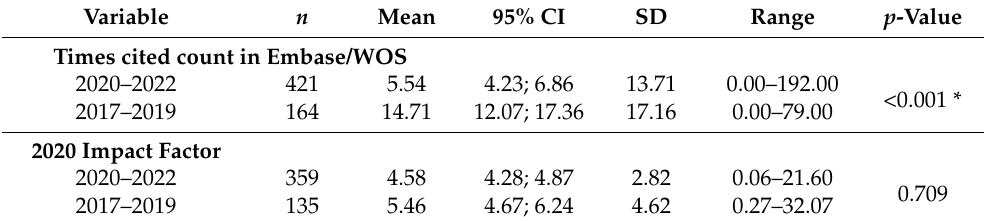
(Table S3), while Health care sciences and service and Respiratory system decreased from 10.95% and 7.30% to 6.87% and 1.65%, respectively. Table 2. Comparison of bibliometric variables according to publication years. Variable n Mean 95% CI Range p -Value